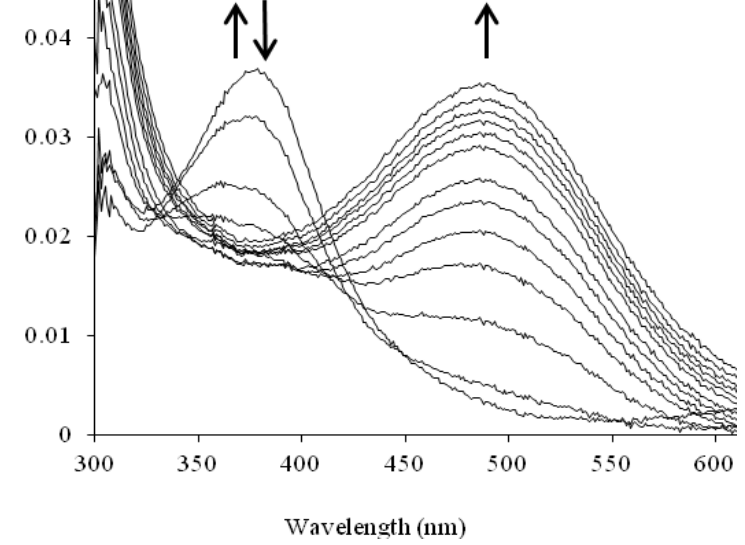
Figure 8. Solution UV/visible spectra showing the time course of the aerobic reconstitution of apoHPAO-1 with Cu(II) at pH 7.0. The directions of change for near-UV/visible absorbance features over time are indicated by arrows. Figure from